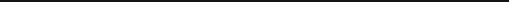
while the scale dependence becomes extremely weak for equilateral models. 22